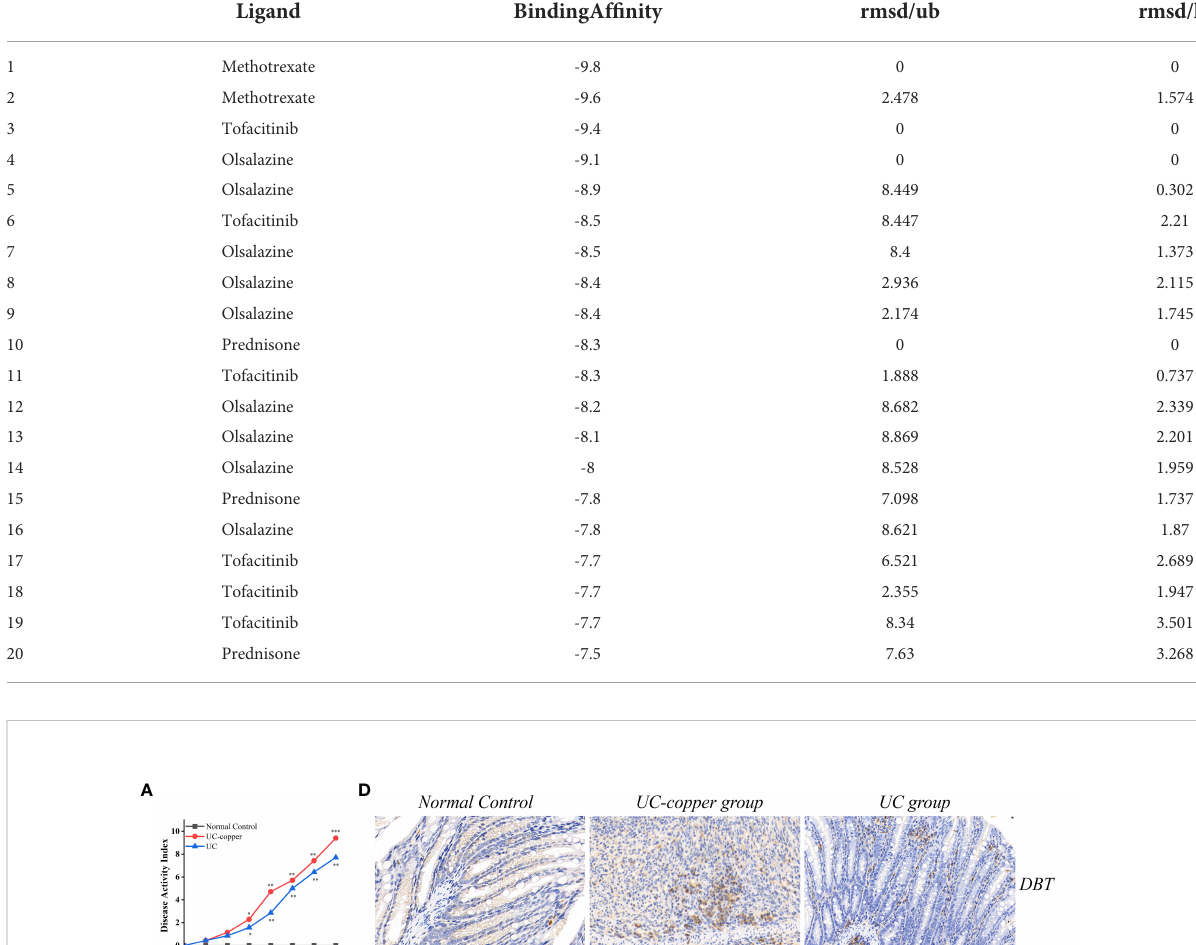
TABLE 2 Docking results of the potent IBD drugs.